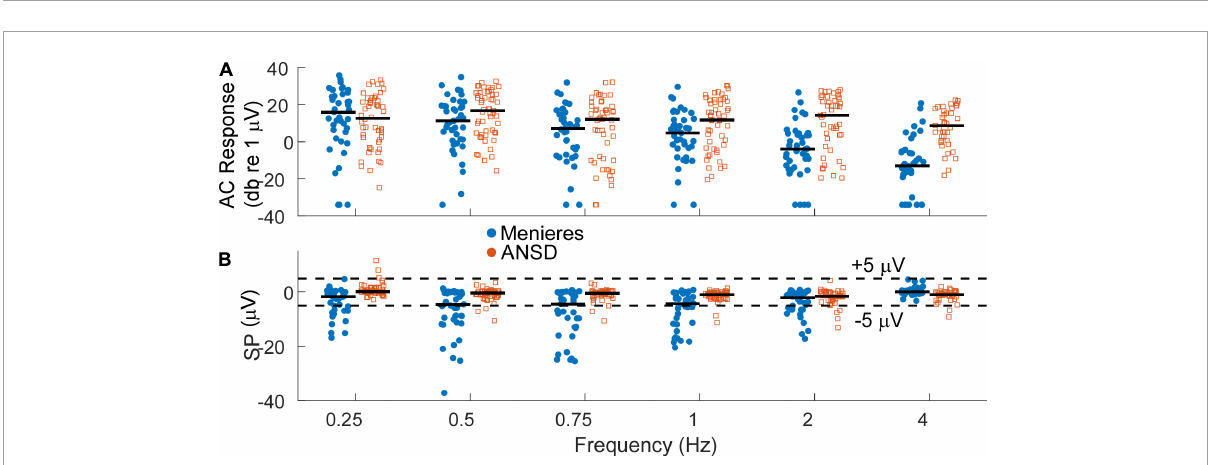
FIGURE3 (A) Distribution of alternating current (AC) response magnitudes by frequency for the Meniere’s disease (MD) (filled blue circles) and auditory neuropathy spectrum disorder (ANSD) (open orange squares) groups. The AC response is measured as the sum of peaks in the spectrum to the first 3 harmonics, if significant compared to surrounding frequencies. To low frequencies in the phase-locking range it can consist of the cochlear microphonic (CM) and auditory nerve neurophonic (ANN) if there is an ANN present, while to high frequencies it consists of the CM. Black bars indicate the group mean. (B) Distribution of the summating potential (SP) magnitude by frequency for both groups. Black bar indicates the group means. Dashed lines indicate ± 5 µ V, roughly separating small from large